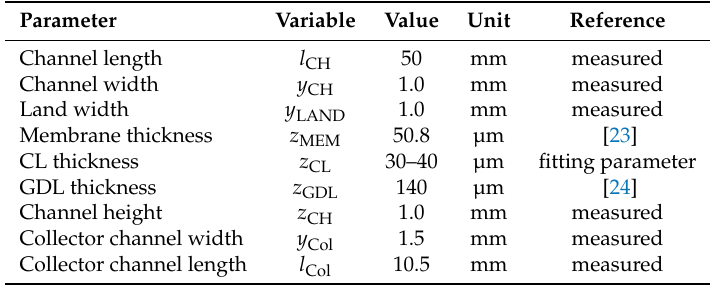
Table A2. Geometric parameters used in the final simulation model.